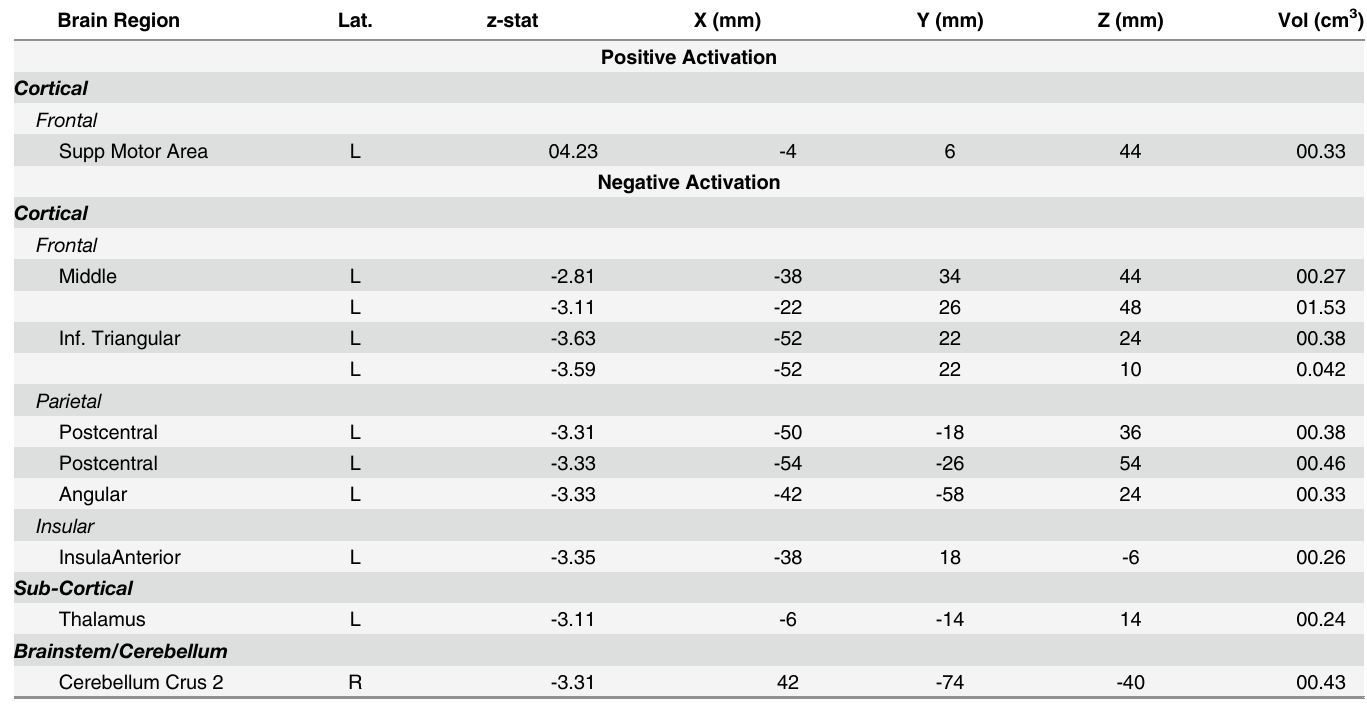
Table 4. Contrast analysis results for painful heat functional MRI activation after sumatriptan administration on the CGRP day. Brain Region Lat.